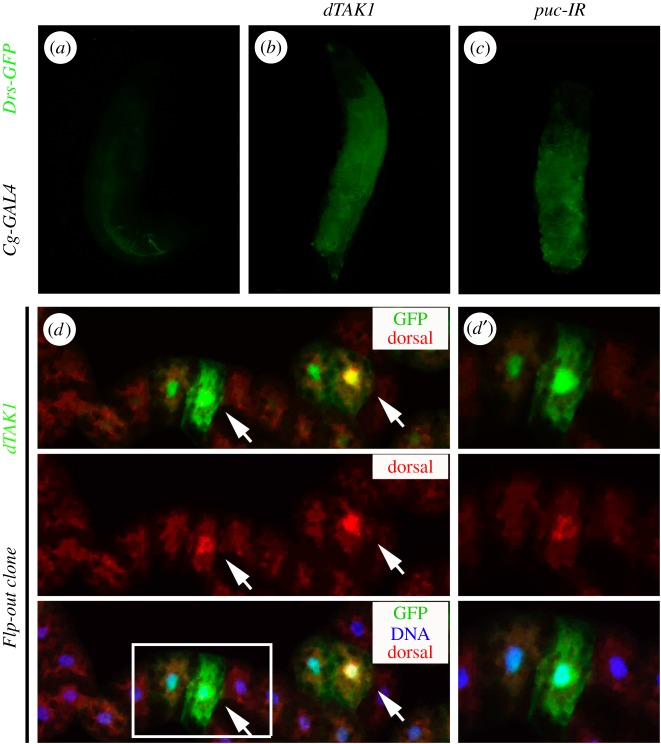
Gain of JNK signalling promotes Drs expression and dorsal nuclear localization. (a–c) Fluorescent microscope images showing third-instar larvae. Compared with control (a), expression of dTAK1 (b) or RNAi inactivation of puc (c) in fat body upregulates Drs-GFP expression. (d) Fluorescent microscope images showing fat body dissected from third-instar larvae stained with anti-dorsal (red). dTAK1-expressing clones were tagged by GFP (green) and induced for 1 h by heat shock at 37°C and recovered for 24 h at 25°C. Nuclei were labelled with DAPI (blue). Endogenous Dorsal protein displays nuclear localization in cells expressing high level of dTAK1 (arrows). (d′) shows high magnification views of the boxed area in (d). DAPI, 4, 6-diamidino-2-phenylindole. See the electronic supplementary material for detailed genotypes.